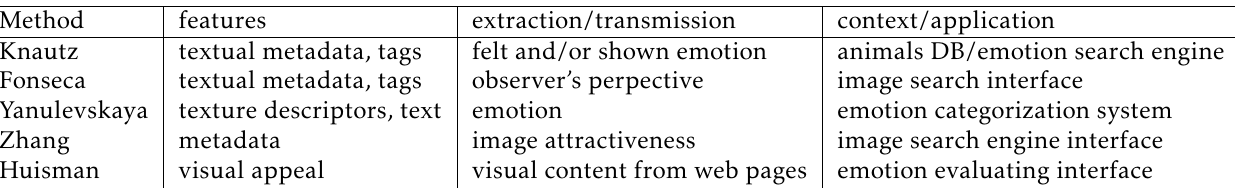
Table 4. Emotion extraction approaches on images